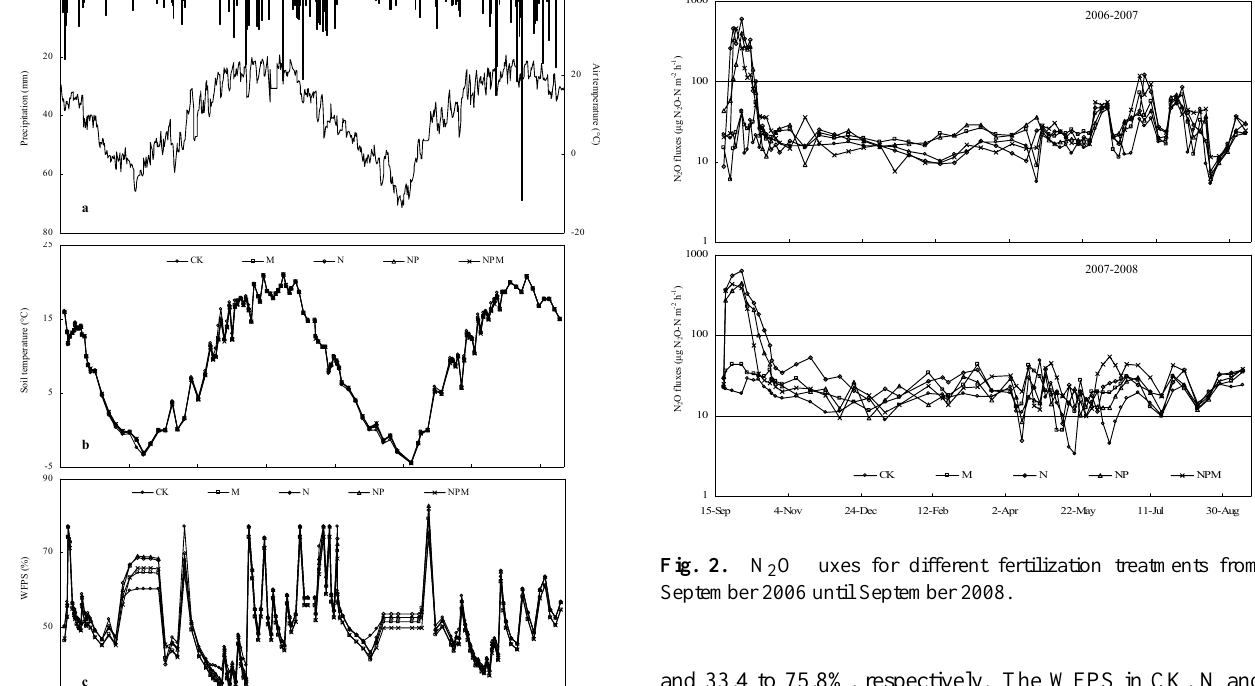
and 33.4 to 75.8%, respectively. The WFPS in CK, N and NP were 3 to 20% higher than in m and NPM. Soil N 2 O fluxes were temporally variable and fertilization dependent (Fig. 2). For the CK treatment, N 2 O fluxes